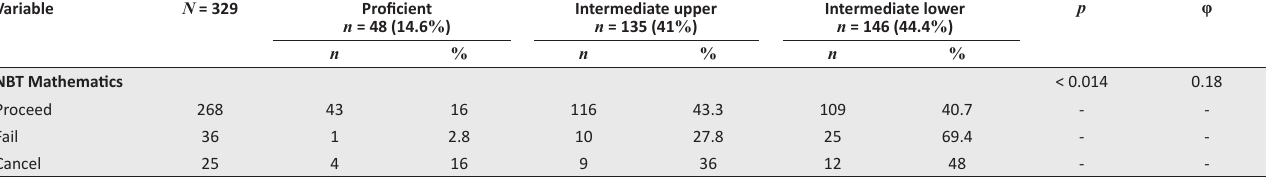
NBT, National Benchmark Test. TABLE 6b: Associations between National Benchmark Test domains and first year Grade Point Average categories. Variable